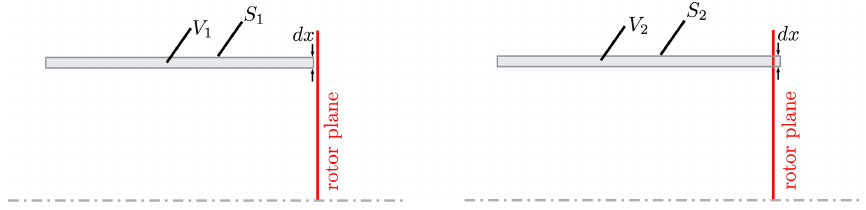
Figure 3. Annular CVs used for the blade-element force analysis. The downstream face of width d x is just upstream and just downstream of the rotor for V 1 and V 2 ,